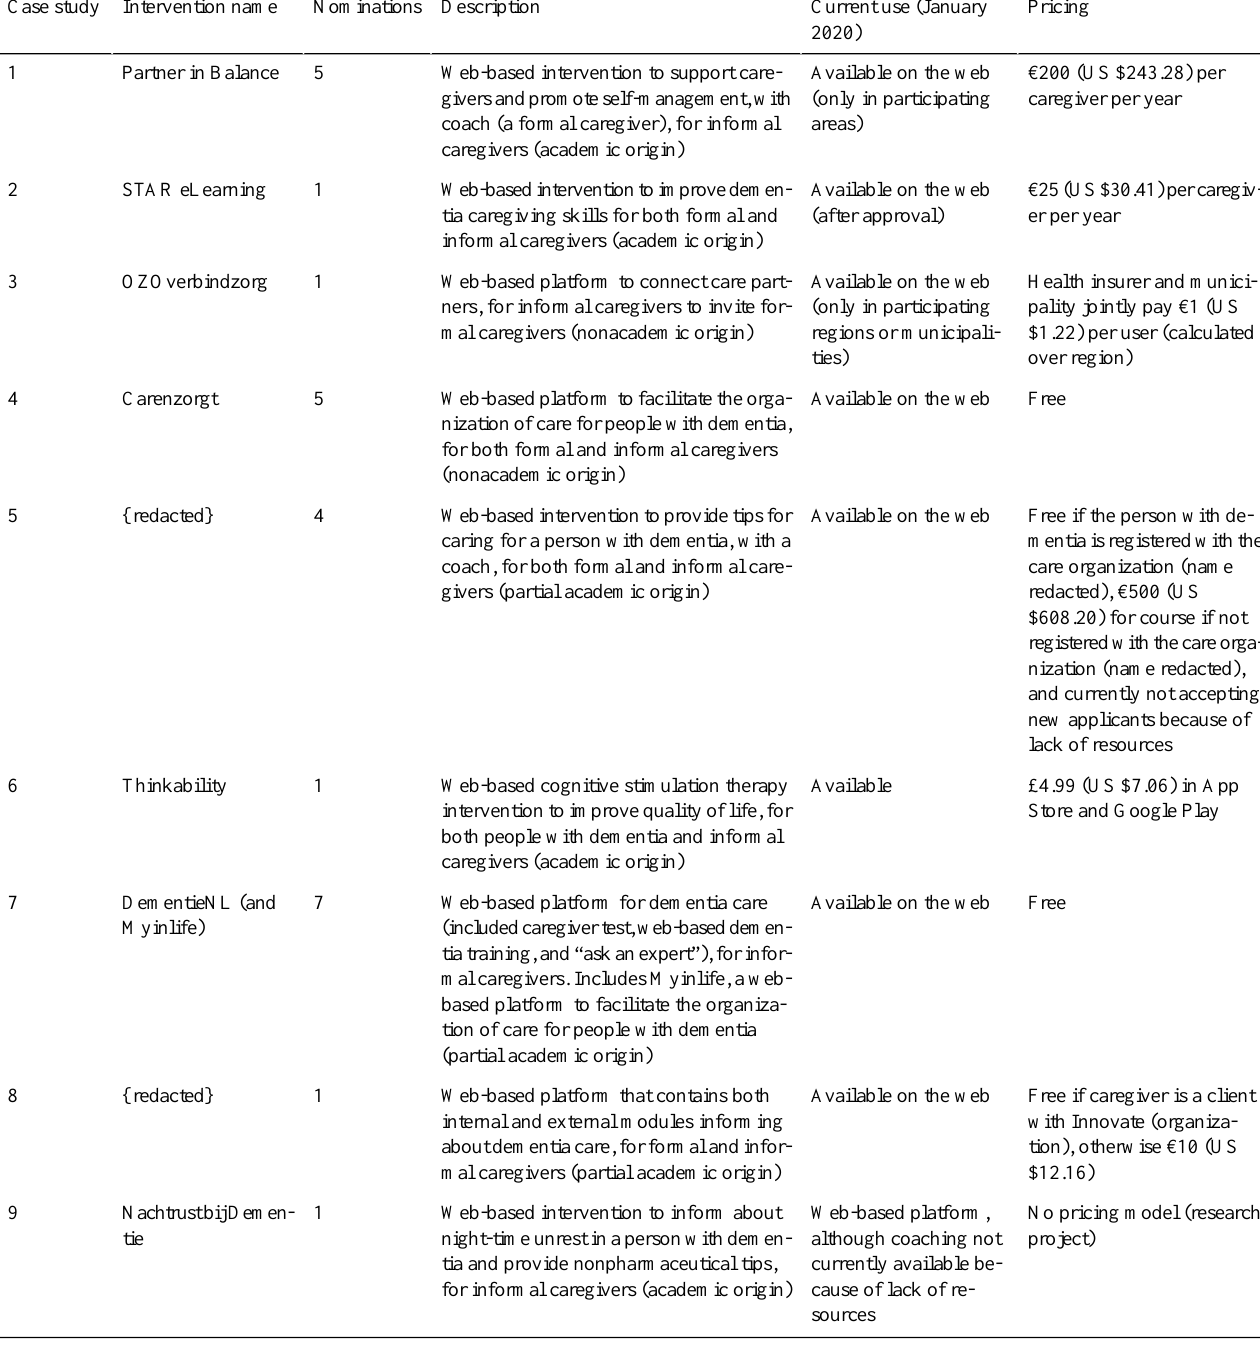
Table 2. Extraction